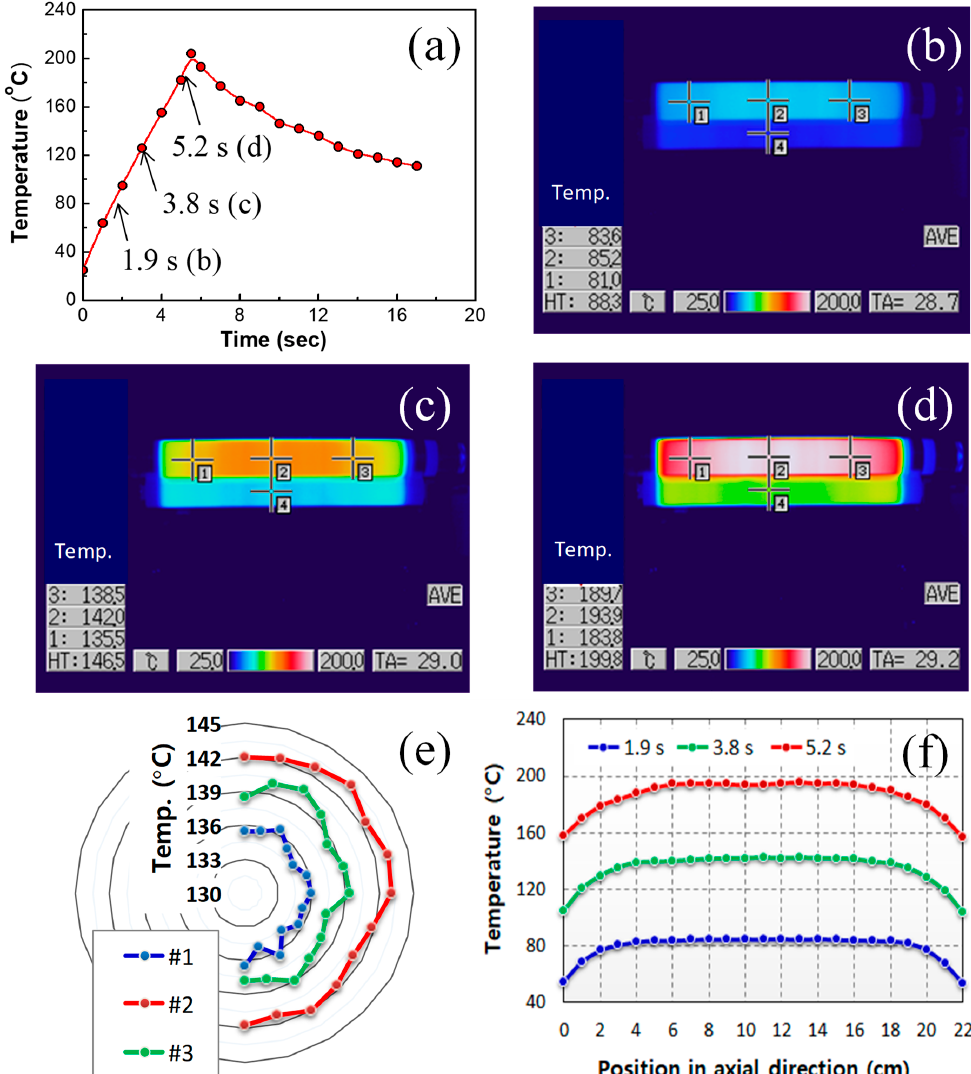
Figure 8. ( a ) Temperature change of MWNT / PDMS fuser with increasing time. Infrared camera images at heating time of ( b ) 1.9 s, ( c ) 3.8 s, and ( d ) 5.2 s. Temperature distribution ( e ) in the circumferential direction at 3.8 s for the three points in Figure 8c, and ( f ) in the axial direction at each moment (1.9 s, 3.8 s, and 5.2 s).